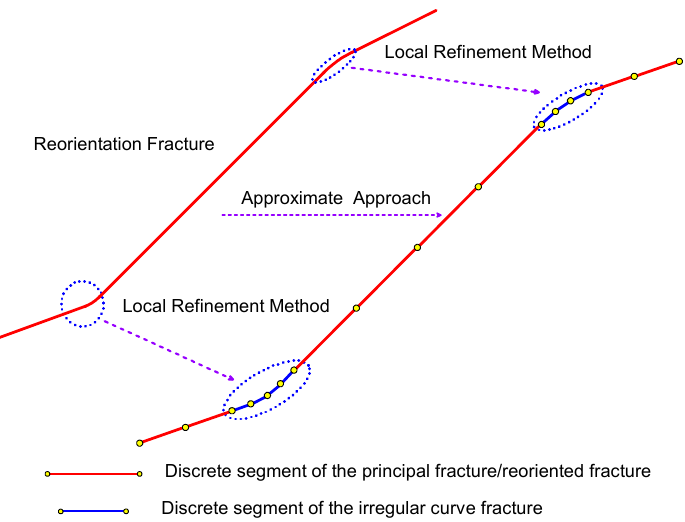
Figure 3. Approximate approach to handle the reorientation fracture.